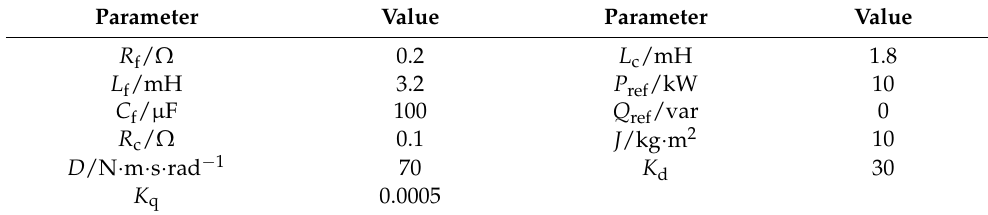
Table 1. Single-VSG system parameters.